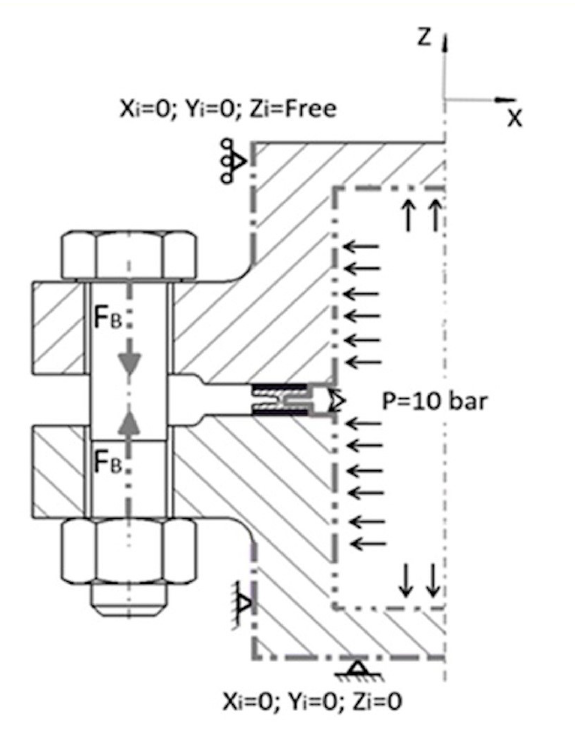
Figure 11: The boundary condition of the computational